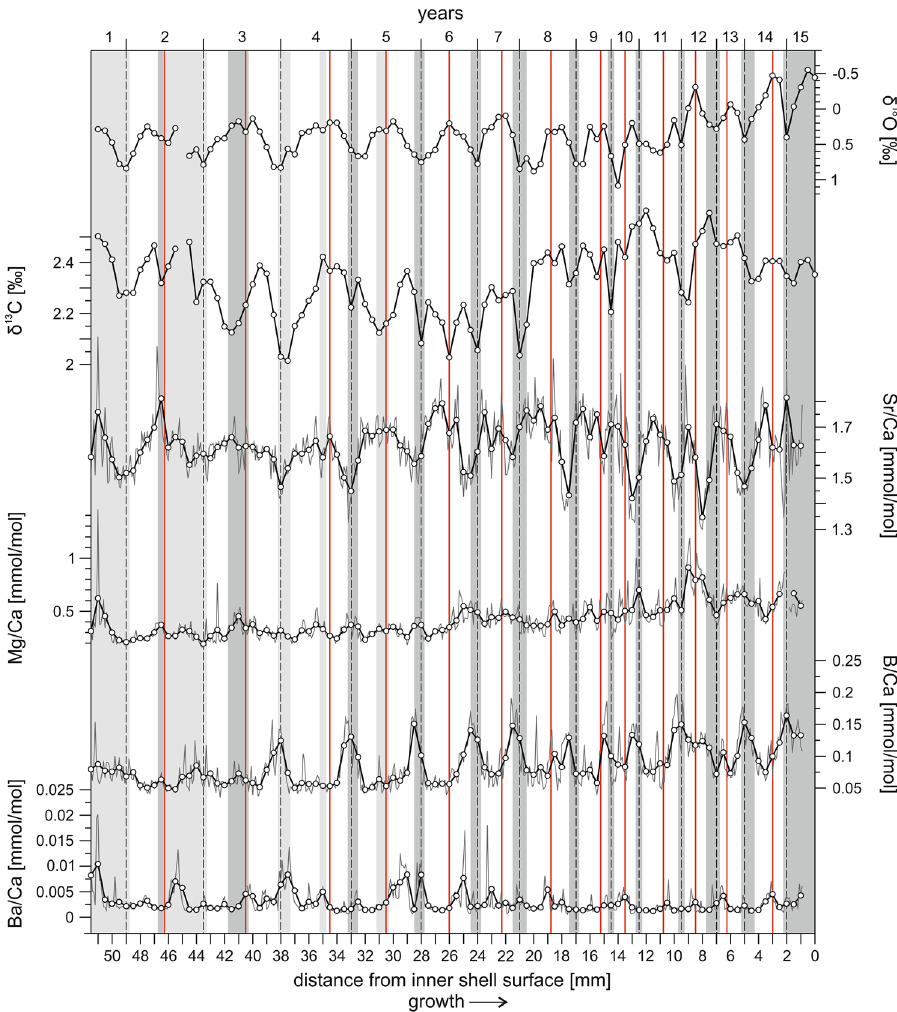
Figure 3. Seasonal variations in the stable isotope and element/Ca composition of T-Fins. Data is plotted as a function of distance from the shell edge. The direction of growth is indicated towards the right (arrow) and most recently secreted layers of carbonate are at 0 mm. Sampled element/Ca data is represented by thin grey lines, with the thicker black line representing the 5 point moving average. Dashed vertical lines define years and vertical red lines indicate upwelling events as deduced from the δ 18 O and δ 13 C data. Vertical grey bars mark the position of dark growth bands as visible along the sampling paths in reflected light (Supplementary Fig.